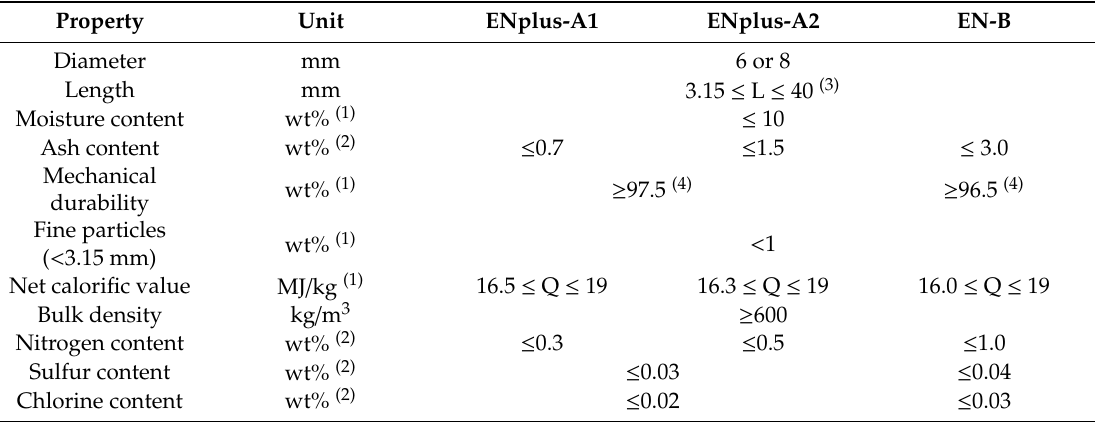
Table 3. Threshold values of the most important pellet parameters